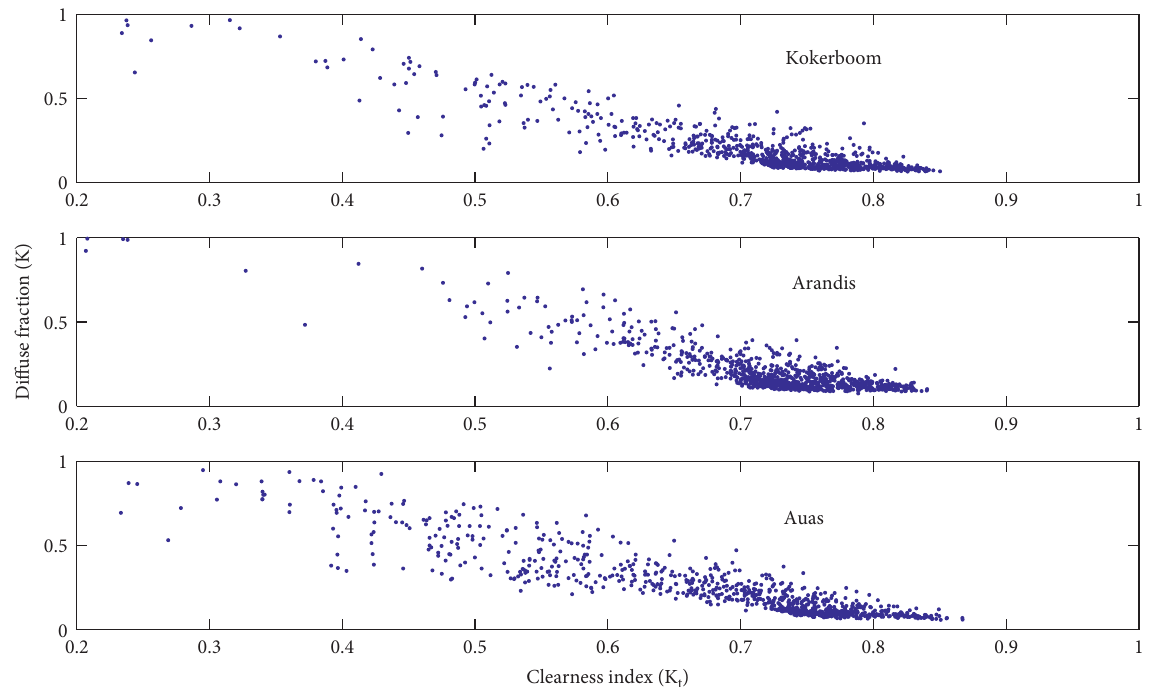
Figure 3: Correlation between daily diffuse fraction and clearness